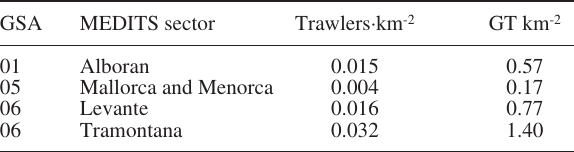
Table 1. – Number of trawlers and gross tonnage (GT) per potential fishing ground surface (km 2 ) in three GFCM geographical sub-areas (GSAs) from the western Mediterranean Sea: GSA01 (Northern Alboran Sea); GSA05 (Balearic Islands); and GSA06 (Northern Spain). Data is given for the different sectors and strata established within the framework of the MEDITS program. Source: Massutí and Guijarro (2004).